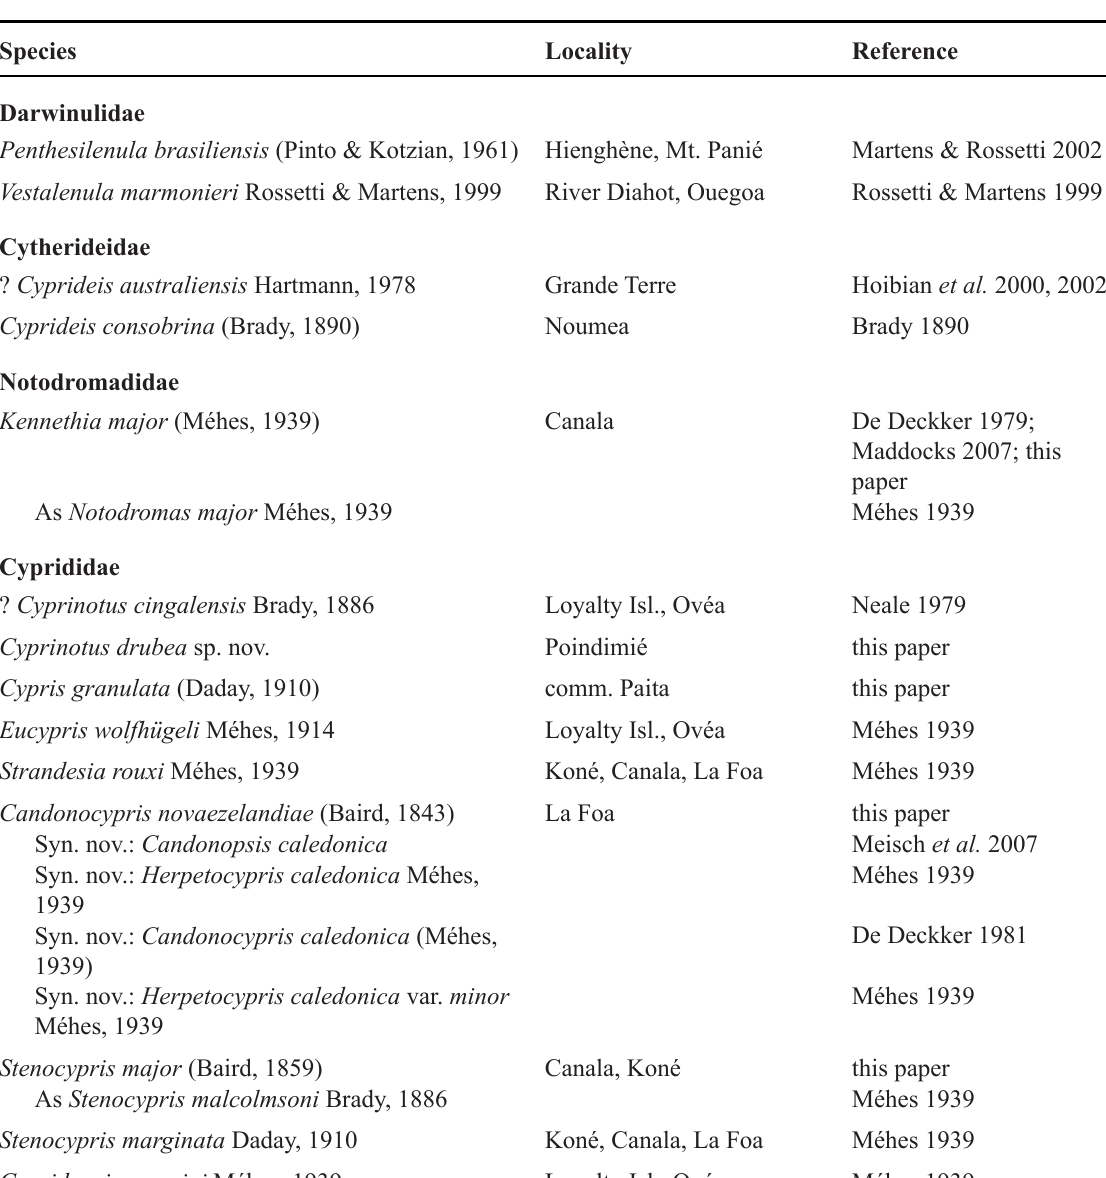
Table 1. Non-marine ostracod species known from New